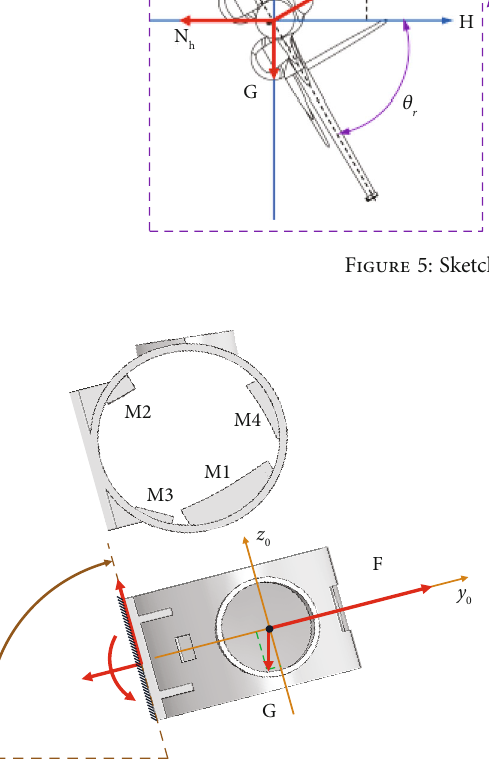
Figure 6: Force analysis diagram of multiplanar conformal o ff -axis four-mirror.